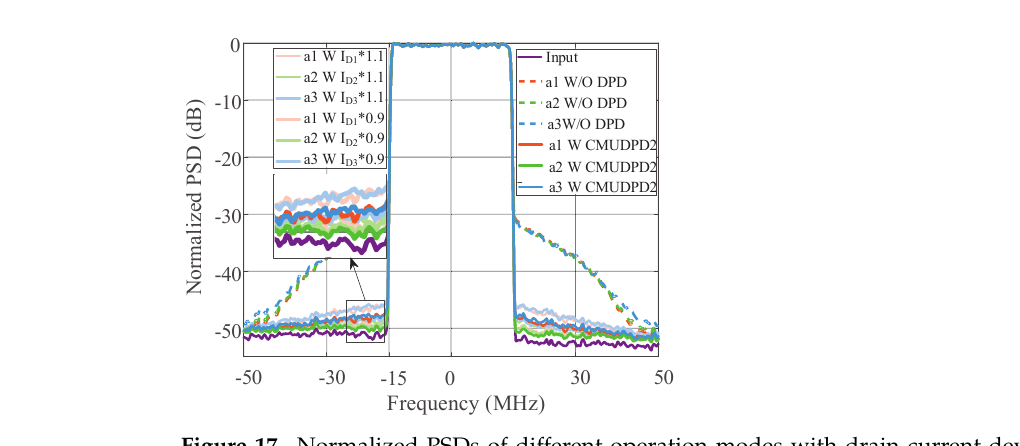
Figure 17. Normalized PSDs of different operation modes with drain current deviations ± 10% (I D1 = 66.82 mA, I D2 = 61.20 mA, I D3 = 63.35